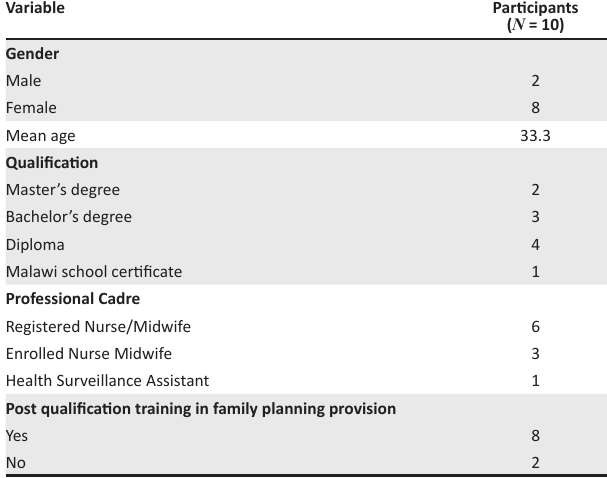
TABLE 2: Baseline characteristics of healthcare